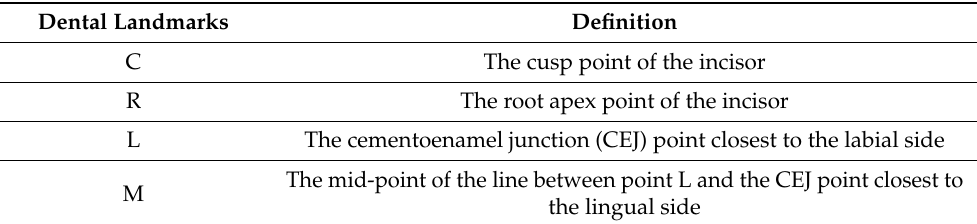
Table 1. Dental landmarks for measuring incisor movement.